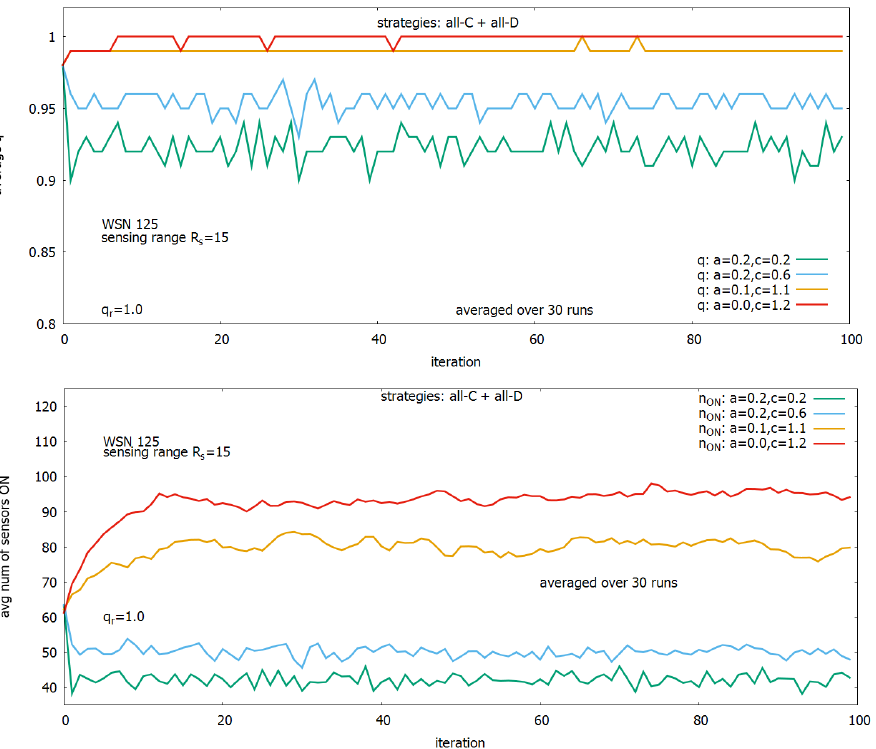
Figure 9. Solving of WSN coverage problem with second-order CA. Evolving in time steps of a final coverage ( upper ) and a corresponding number of active sensors ( lower